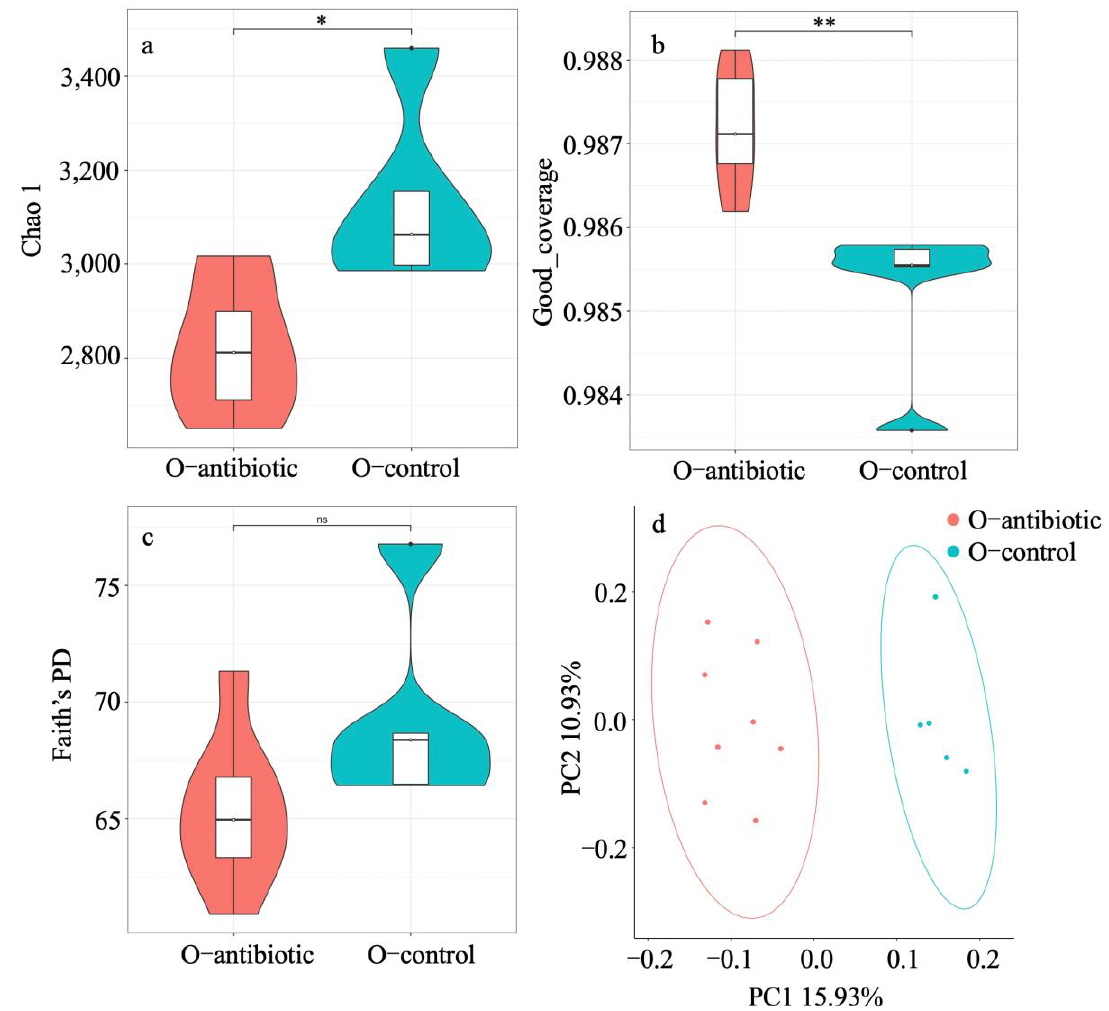
Figure 3. Comparison of the Chao 1 ( a ), good_coverage ( b ) and Faith’s PD ( c ) and principal-coordinates analysis (PCoA) based on unweighted UniFrac distance matrix ( d ) of 14-week old offspring born to antibiotics-treated mothers and controls. O-antibiotic and O-control stand for offspring born to antibiotics-treated mothers and controls, respectively. Statistical significance: *, p < 0.05; **, p < 0.01; ns, not significant. Presence of ellipses is indicative of a 95% confidence interval of β -diversity